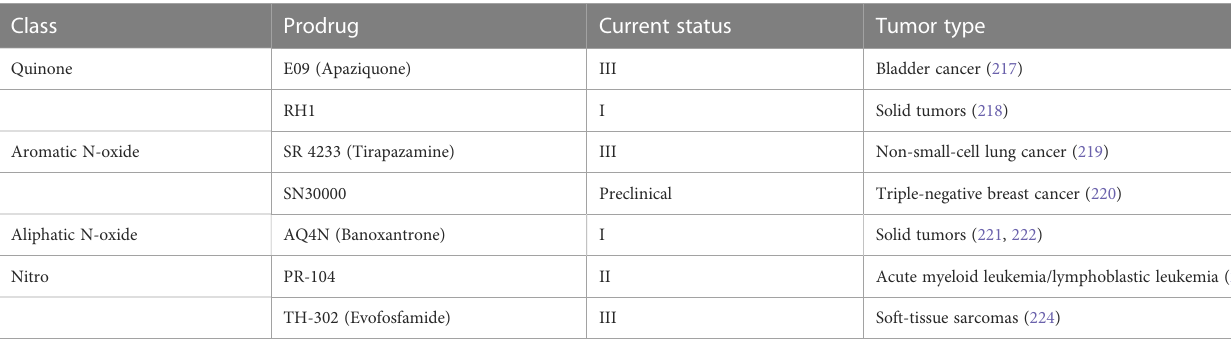
TABLE 4 Hypoxia-activated prodrugs in clinical development.